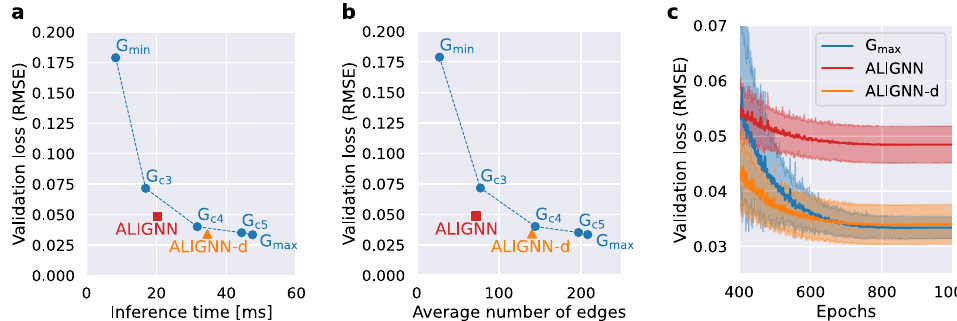
Fig. 4 Comparison of validation loss for the graph representations studied in this work. The validation loss, which is averaged over 8 repeated training sessions each with random initialization, is plotted with respect to a inference time, b average number of graph edges, and ( c ) in-training epochs. In a , the inference time is averaged over mini-batches of 64 random samples. In c , the ± 1 standard deviation of the validation loss from the repeated training sessions is shown as the semitransparent regions.